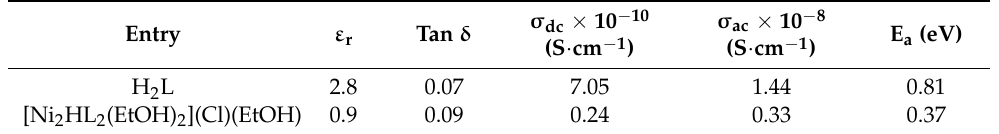
Table 2. Room temperature values of the dielectric and electrical parameters for H 2 L and